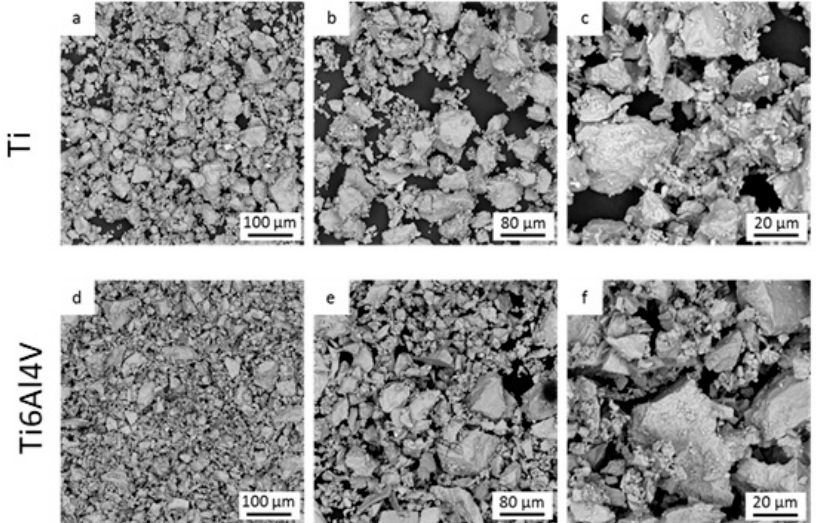
Figure 5. Particles released observed by SEM. ( a – c ) Titanium particles observed at different magnifications. ( d – f ) Ti-6Al-4V alloy particles observed at different magnifications.